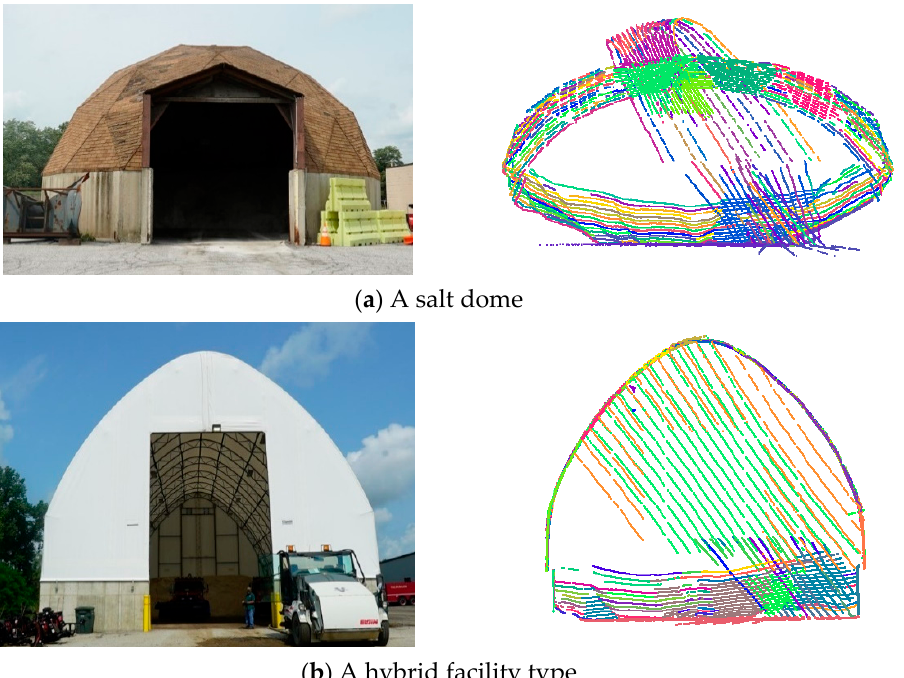
Figure 32. Examples of warehouses with non-planar building structures ( left ) and segmented LiDAR scan ( right ) (point clouds are colored by feature).